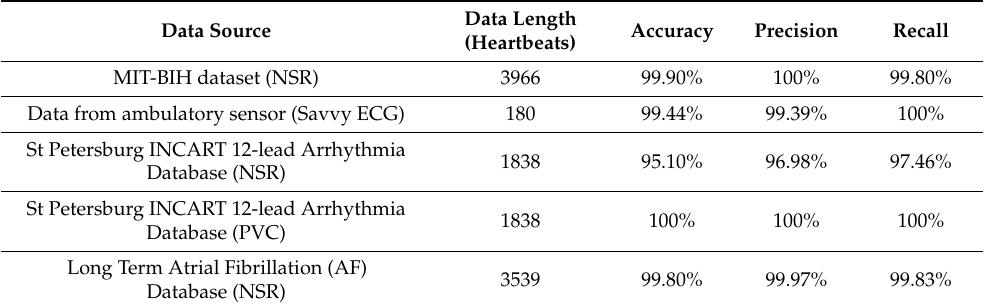
Table 1. Testing results of different data sources.